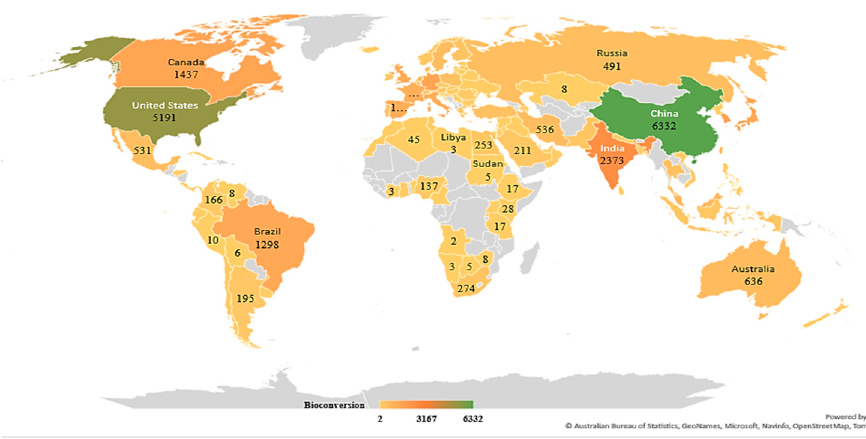
Figure 3. Geographical distribution of bioconversion research during the last five years (2017–2022).